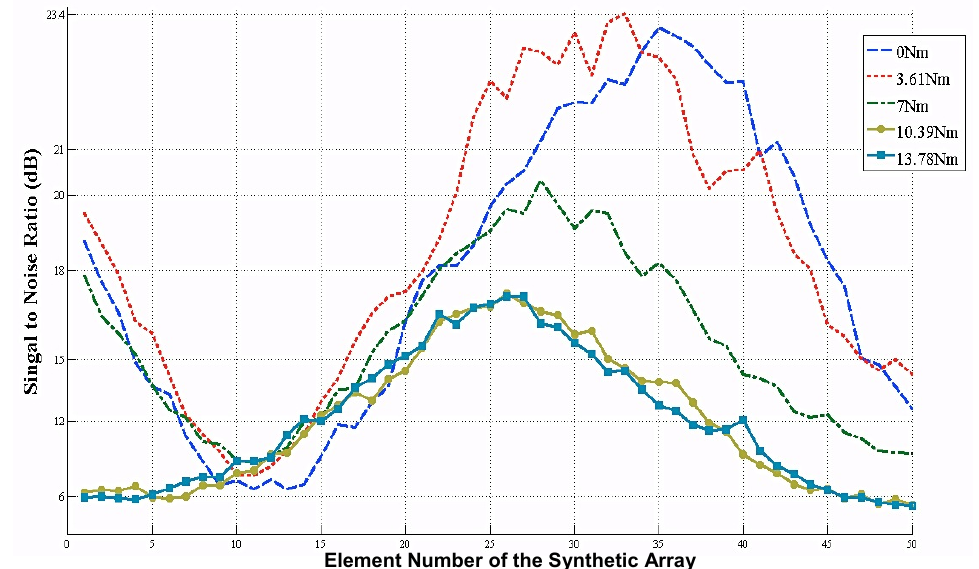
Figure 8. Signal to noise ratio of the bolt reflections based on original signals.